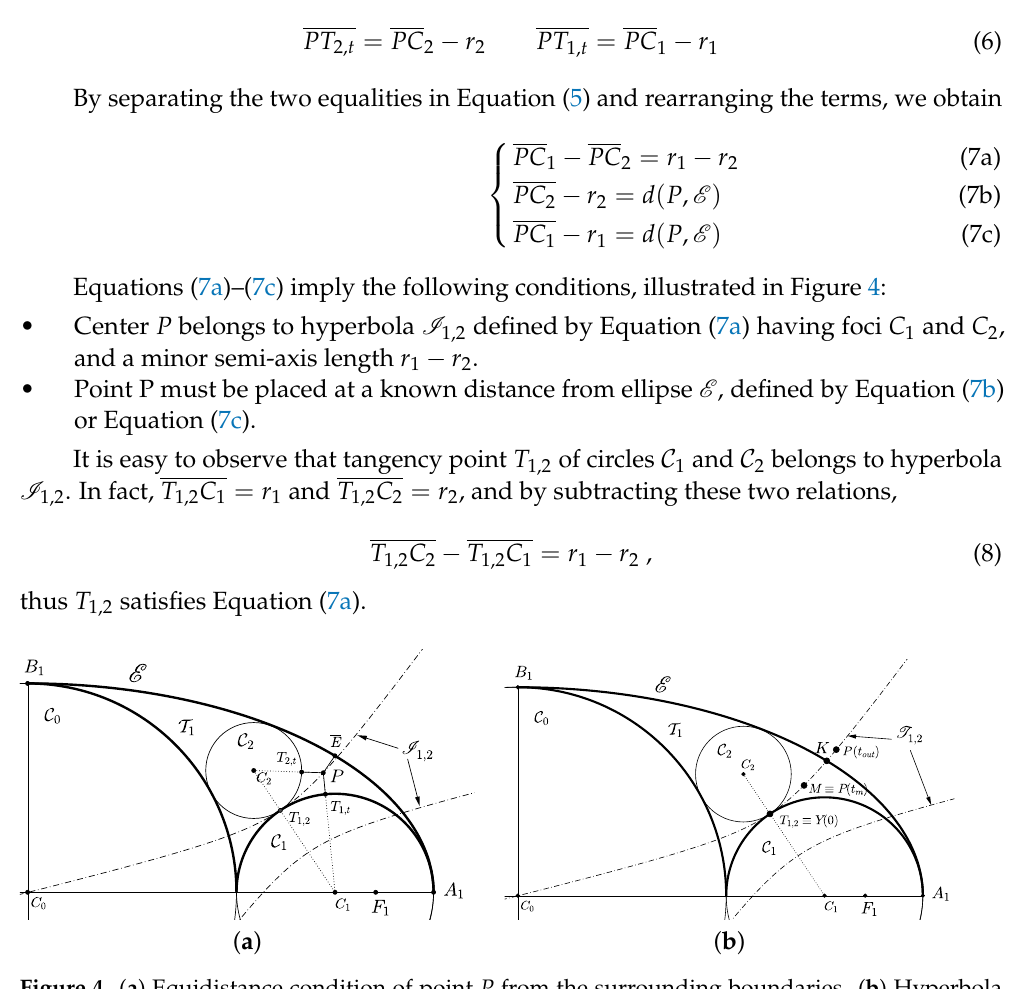
Figure 4. ( a ) Equidistance condition of point P from the surrounding boundaries. ( b ) Hyperbola expressing the condition of equidistance of point P from circles C 1 and C 2